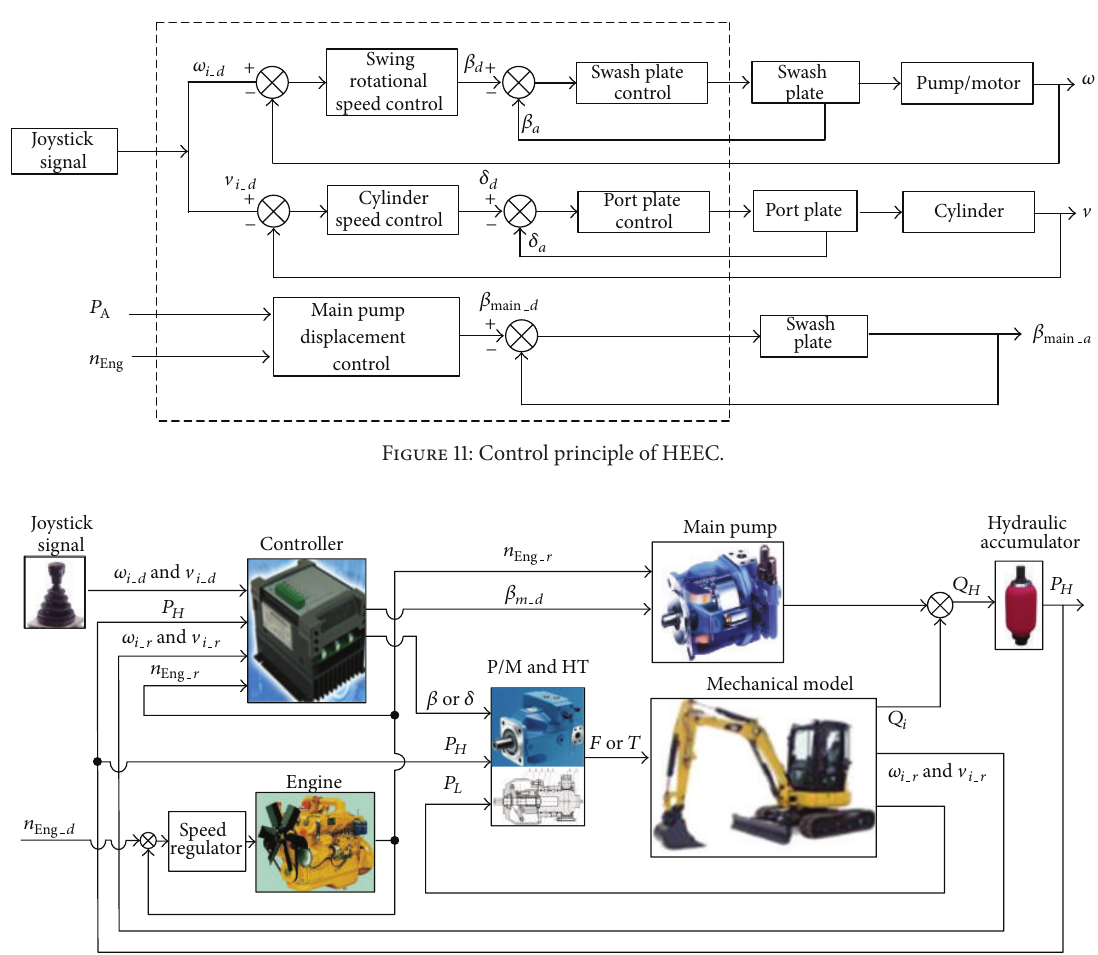
Figure 12: Top module of the whole simulation